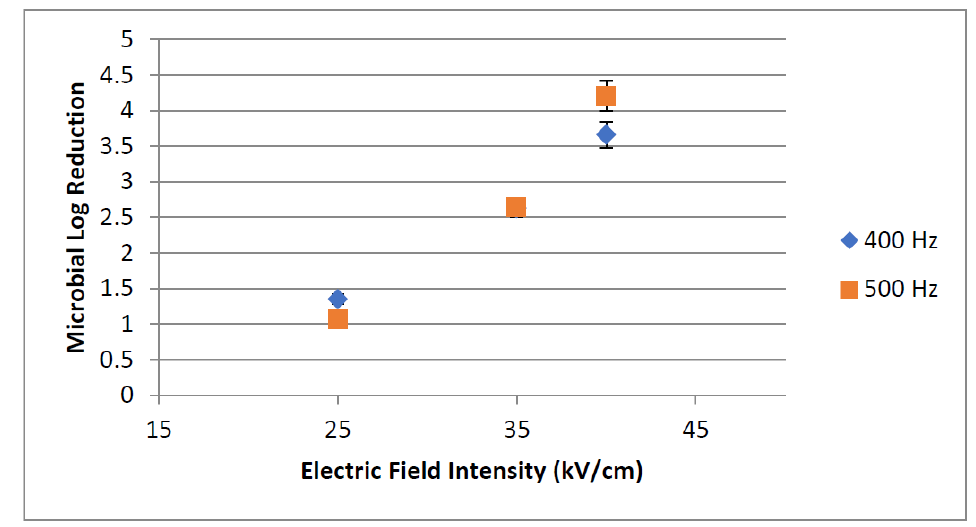
Figure 8. The effect of electric field intensity (40, 35 and 25 kV/cm) using two different frequencies (400 and 500 Hz) on the E. coli population suspended in the diluted protein shake beverage using a flow rate of 12.01 mL/s.